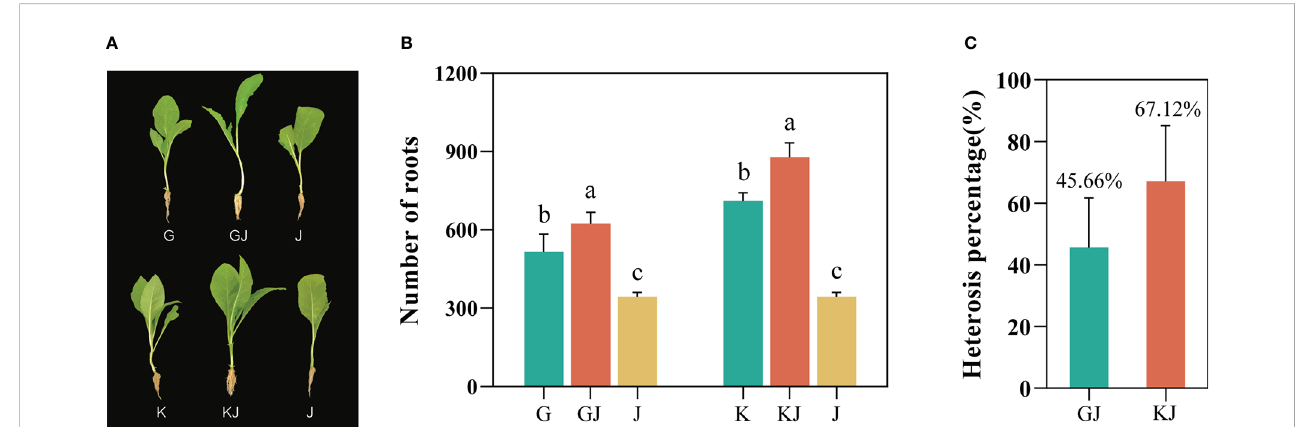
FIGURE 1 Phenotypic parameters and Heterosis of two tobacco F1 hybrids and their parents. (A) Photographs of the two hybrids and their parents used in this study. (B) Root number of F1 hybrid and its parents(G = G70, J = Jiucaiping No.2, GJ = G70 × Jiucaiping No.2, K = K326, KJ =K326 × Jiucaiping No.2).